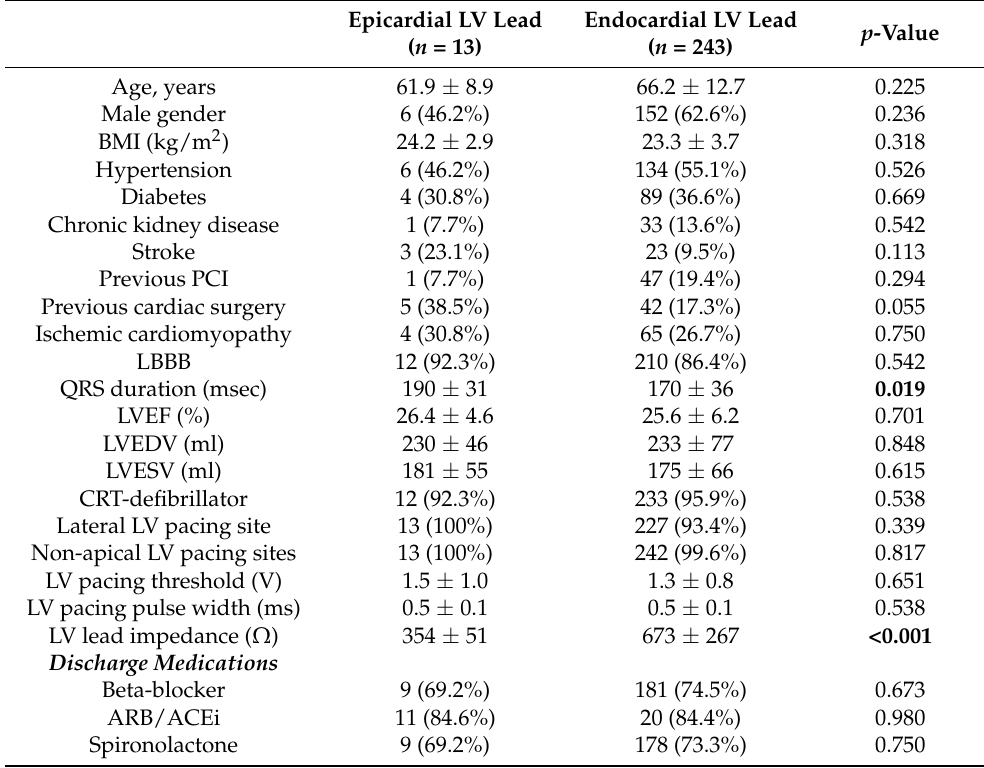
Table 2. Baseline